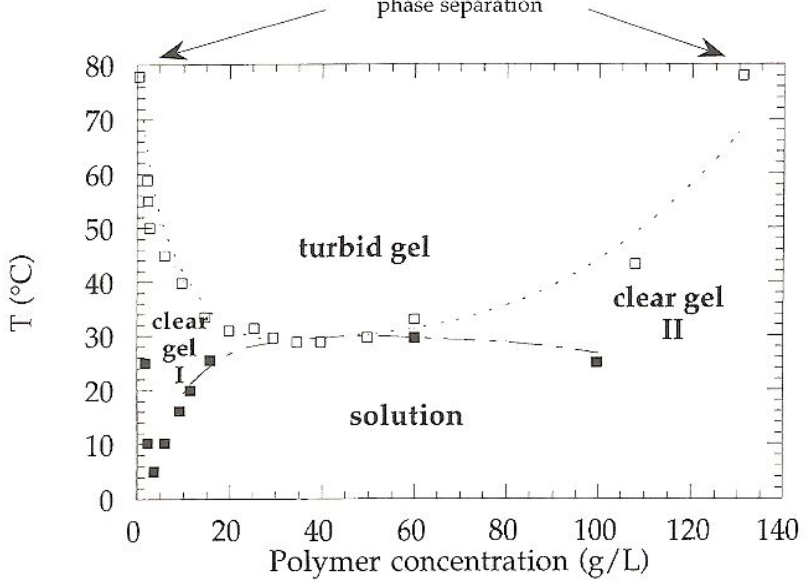
Figure 1. Phase diagram of an aqueous A4C methylcellulose solution (DS = 1.7 from Dow Chemical) including the cloud point curve (  ) and the sol-gel line (  ) determined from oscillatory measurements [2]. Reproduced from Polymer 1998 , 39, 6251-6259. Copyright 2010,